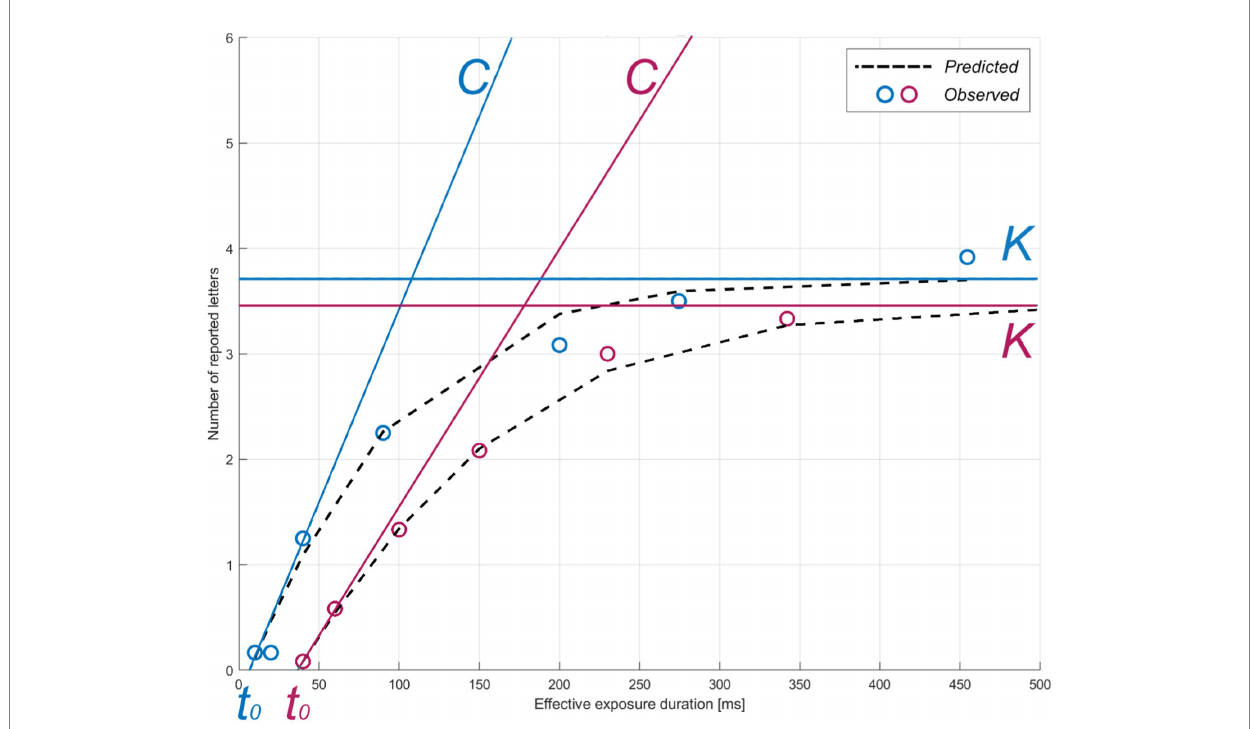
FIGURE 2 TVA parameter estimation for two representative participants. The theory of visual attention (TVA) estimation curve for accuracy as a function of exposure duration is shown for two example individuals (pink: greater subjective cognitive complaints, z -score = 1.09; blue: lower subjective cognitive complaints, z -score = − 0.860) in the whole-report task. Parameters: C = visual processing speed; K = visual short-term memory storage capacity; t 0 = visual perceptual threshold. Circles indicate each individual’s mean observed performance across conditions. The dotted black curves indicate each individual’s predicted performance across exposure